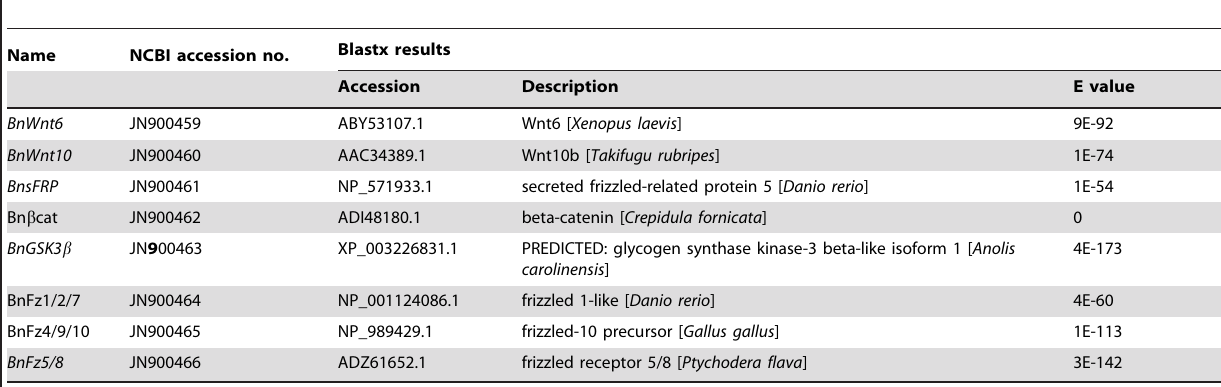
Table 2. Blastx results in comparison with the full-length cDNA of corresponding